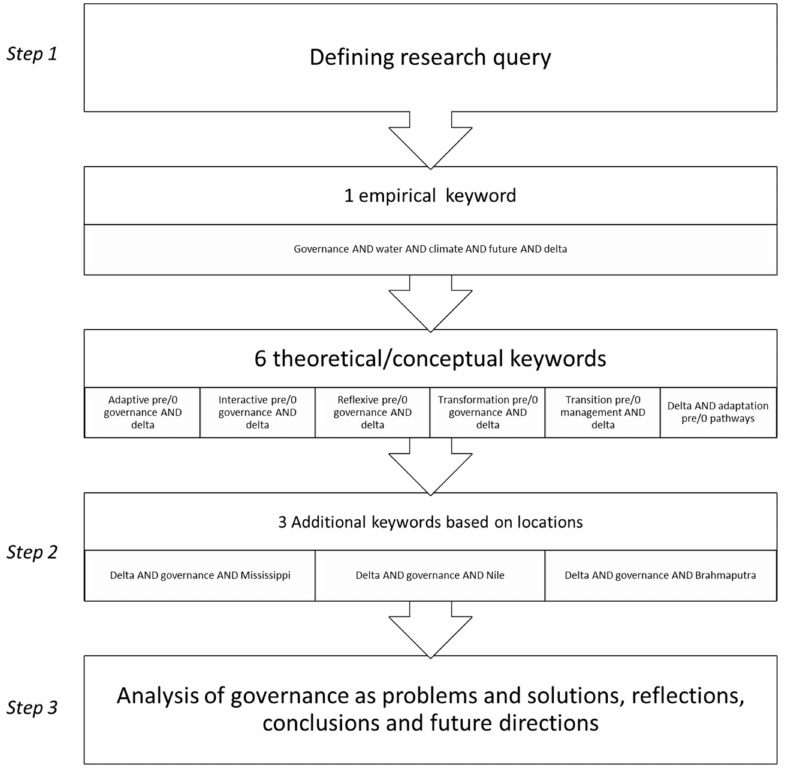
Figure 1. Methodological